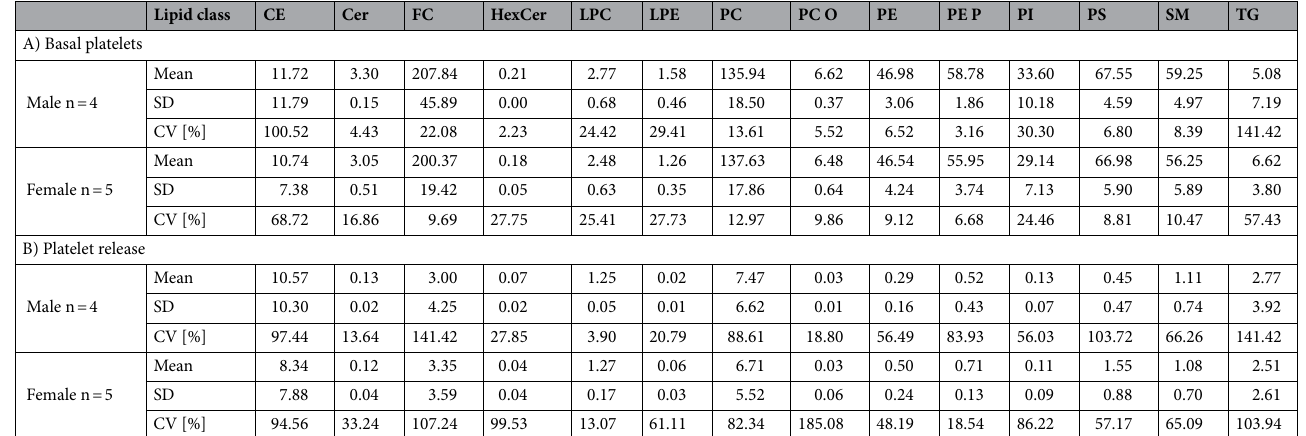
Table 1. Intra-donor variation. Displayed are mean, SD [nmol/10 9 platelets] and CV (coefficient of variation) for basal platelets ( A ) and lipid release upon thrombin stimulation ( B